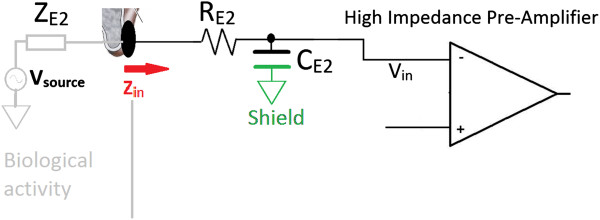
Electrical model of electrode Shield.